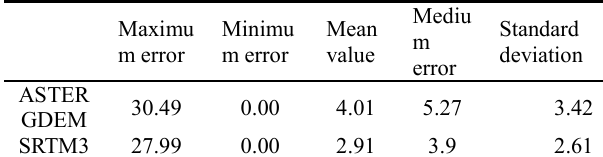
Table2 Test area B elevation differences unit ： m